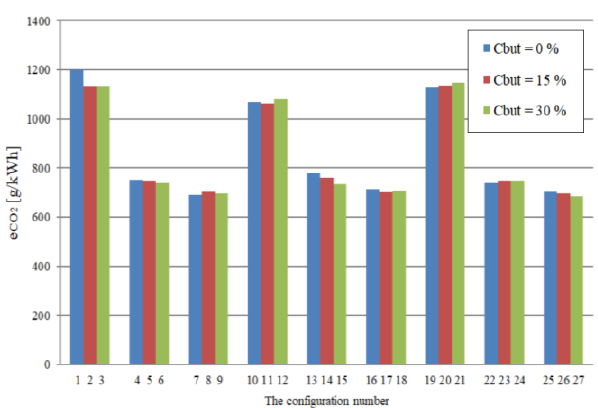
Fig. 6. Comparison of the specific CO 2 emission for the engine fed with blended n-butanol fuel and MDF